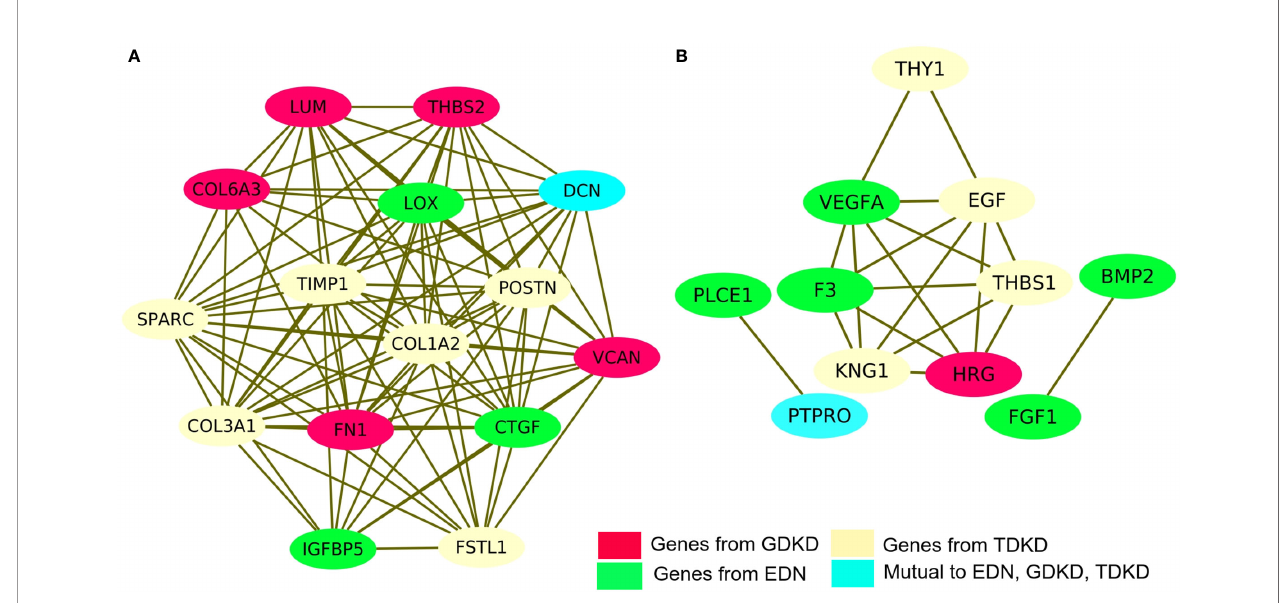
FIGURE 4 | Protein – protein interaction (PPI) network of DEGs and module analysis. (A) Identi fi cation of a signi fi cant module based on the degree of importance examined for upregulated DEGs. (B) Identi fi cation of a signi fi cant module based on the degree of importance examined for downregulated DEGs. The representations are as follows: the potential genes unique to EDN, GDKD, and TDKD are shown in green, pink and cream colors respectively. The cyan color represents the common gene noticed in all three datasets for the respective up- and downregulated